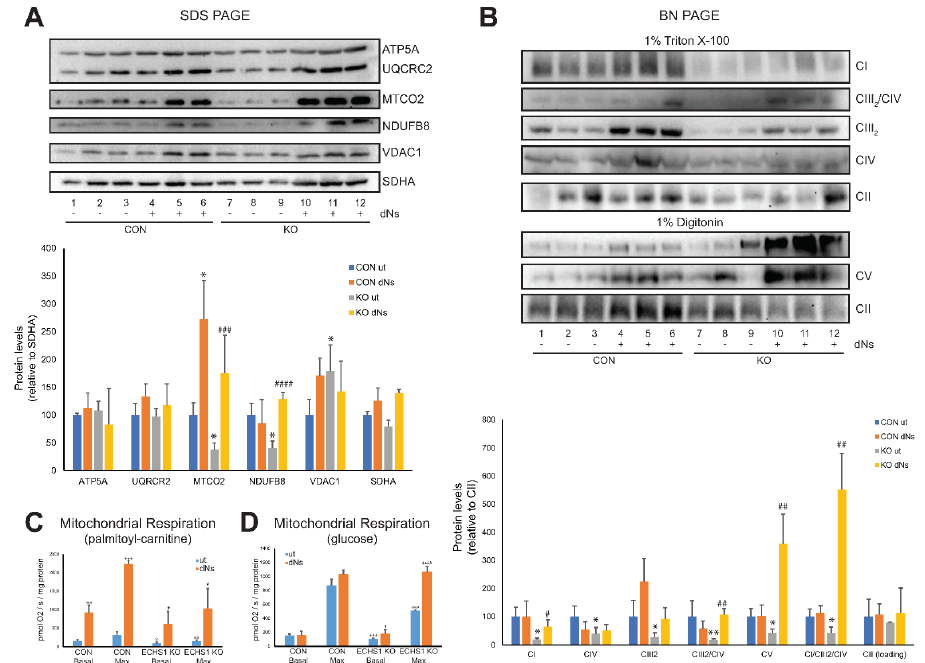
Figure 4. dNs treatment increases steady-state OXPHOS complex levels and mitochondrial respira- tory capacity. ( A ) SDS-PAGE reveals that steady-state levels of NDUFB8 (complex I) and MTCO2 (complex IV) are decreased in untreated ECHS1 KO cells compared to untreated control CON cells, but increase following eight days of dNs treatment to control levels. ( B ) BN-PAGE reveals that steady-state levels of OXPHOS complexes I, III 2 , IV and the CIII 2 /CIV and CI/CIII 2 /CIV supercom- plexes are reduced in untreated ECHS1 KO cells compared to untreated CON cells. Treatment with dNs increased the levels of complex I, complex V, and the CIII 2 /CIV and CI/CIII 2 /CIV supercom- plexes in ECHS1 KO cells to levels similar or above those in untreated CON cells. ( C ) Mitochondrial respiration rates using palmitoyl-L-carnitine as substrate. Untreated ECHS1 KO cells had reduced basal and maximal respiration rates compared to untreated CON cells. dNs treatment increased both rates in ECHS1 KO cells to levels above those in untreated CON cells. ( D ) Mitochondrial res- piration rates using glucose as substrate. Untreated ECHS1 KO cells had reduced basal and maximal respiration rates compared to CON cells. dNs treatment increased both rates in ECHS1 KO cells to levels similar to CON cells. Data shown is mean ± s.d., with n ≥ 3. * p < 0.05, ** p < 0.01, *** p > 0.001 compared to untreated (ut) CON cells; # p < 0.05, ## p > 0.01, ### p > 0.001, #### p > 0.0001 compared to untreated (ut) ECHS1 KO cells (Student’s two -tailed t tests). Images shown are representative of three independent experiments.